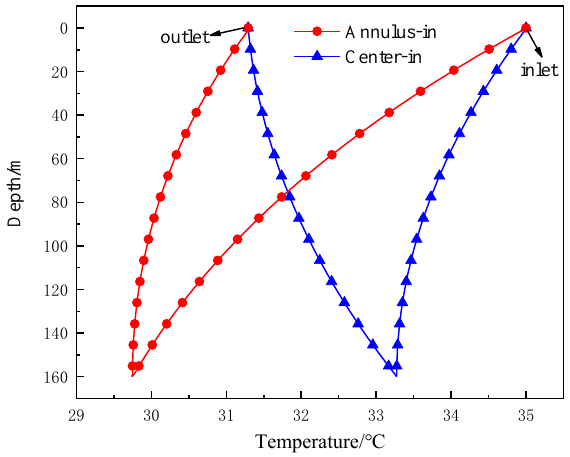
Figure 11. Fluid temperature profile.